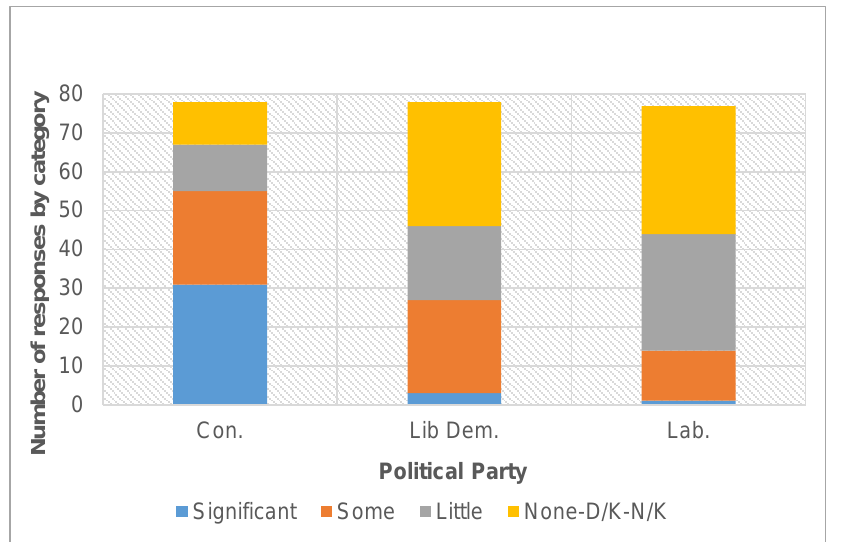
Figure 4: Participants’ assessments of loci of influence over rural policy in West Dorset ‘main political